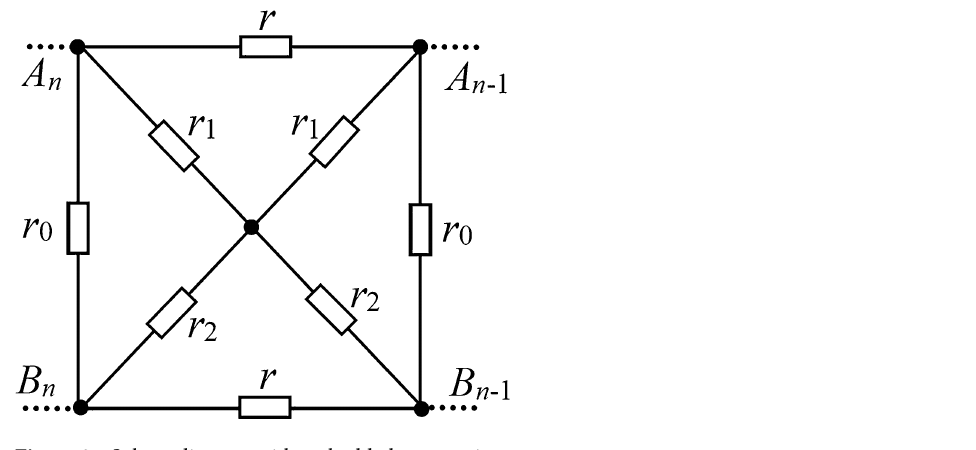
Figure 3. Subnet diagram with embedded cross